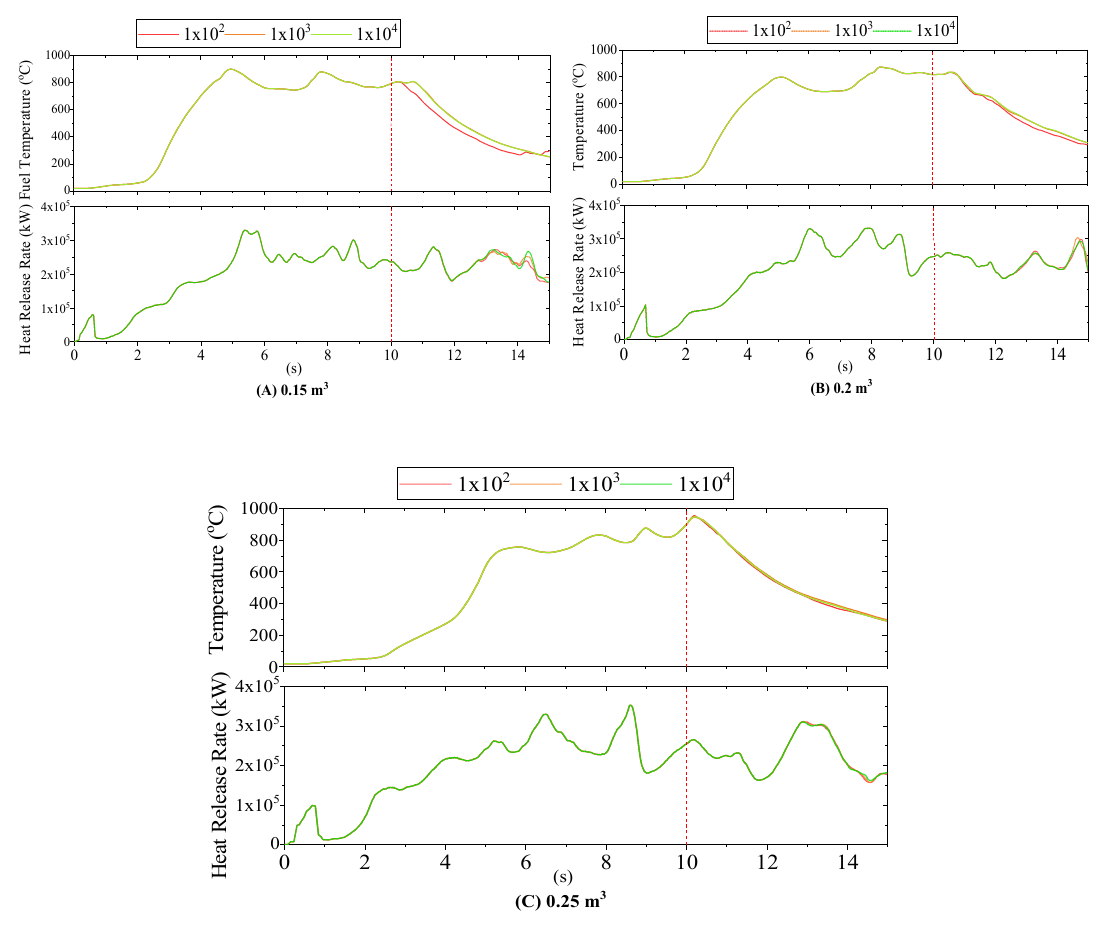
Figure 6. Droplets per seconds with variable cell size. ( A ) 0.15 m 3 , ( B ) 0.2 m 3 , ( C ) 0.25 m 3 .